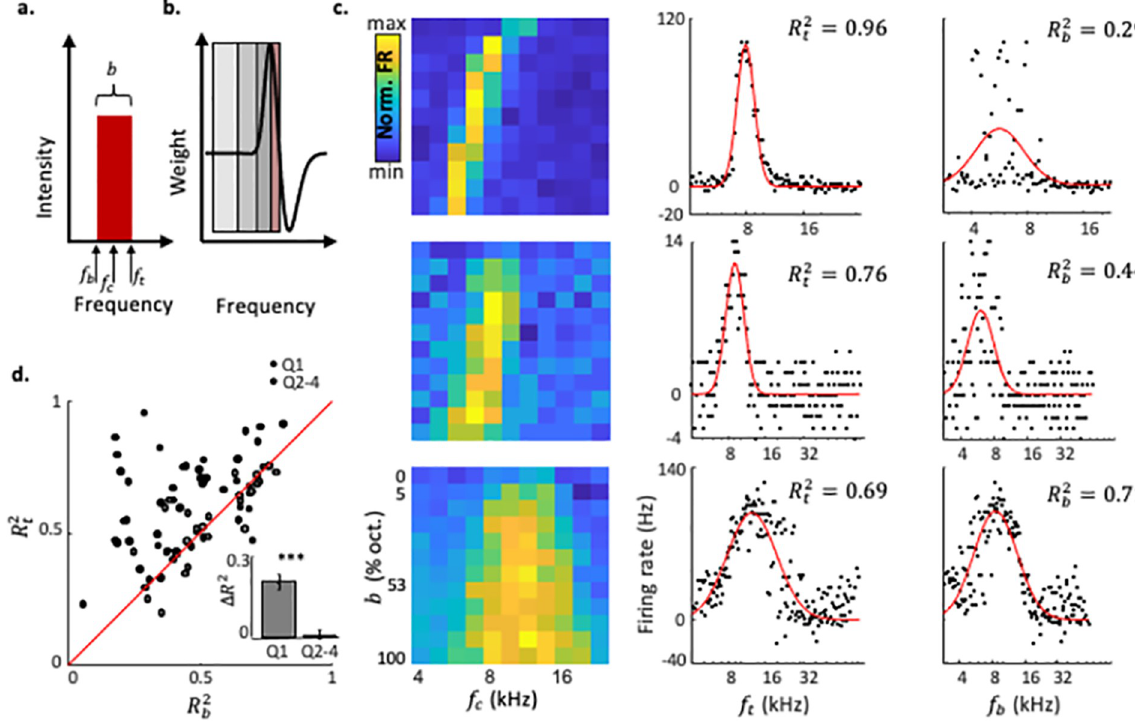
Fig 5. Cortical neurons selective for top-frequency. a. Illustration of a BBS. The bottom, center, and top frequencies are marked by arrows. b — bandwidth. b. A schematic demonstration of top-frequency selectivity. Three different stimuli (3 shades of grey) having the same f and varying t f c , all have a complete overlap with the excitatory band of the tuning curve and will consequently evoke the same response. Only a sufficiently narrow stimulus with the same f (red) will evoke a weaker response—demonstrating that top-frequency selectivity is true for stimuli with some t minimal bandwidth. c. Left: FBRAs of 3 example neurons. Middle and right: Tuning curves of the 3 example neurons shown on the left sorted by f or f of all stimuli. Black dots are data points corresponding to the firing rate at each stimulus. Red line is a fitted gaussian. The quality of fit t b for each tuning curve to a gaussian are shown on the top right of each plot. d. The quality of fit for each tuning curve when the tuning curve is plotted as top frequency (Y axis) versus bottom frequency tuning curves (X axis). Red line is the identity line. Q1 neurons are plotted separately (filled circles) to Q2-4 neurons (open circles). Inset: A bar graph showing D R 2 ¼ ð R 2 (cid:0) R 2 Þ . Neurons from Q1 have significantly higher R 2 ‘s t b t (student’s t-test, p < 10 − 6